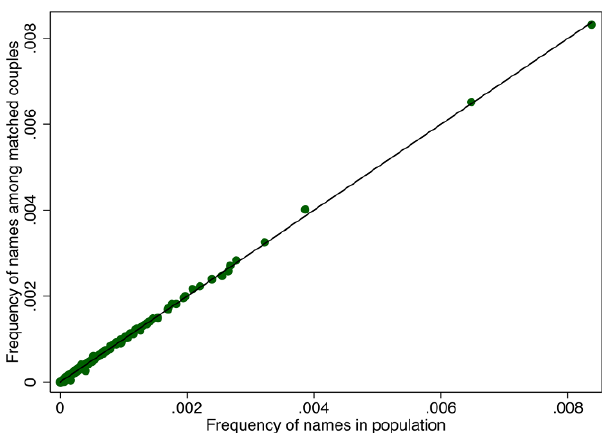
Fig. 6 Frequency of Surnames in Population and Among Matched Couples. (Note: Each dot in the figure represents one unique last name in our data (such as Meier or Mueller). The figure shows the frequency of each last name in the overall population (x-axis) and among the sam- ple of matched couples (y-axis). The black line represents the 45 degree line, suggesting that most names are equally common in the overall population and among matched